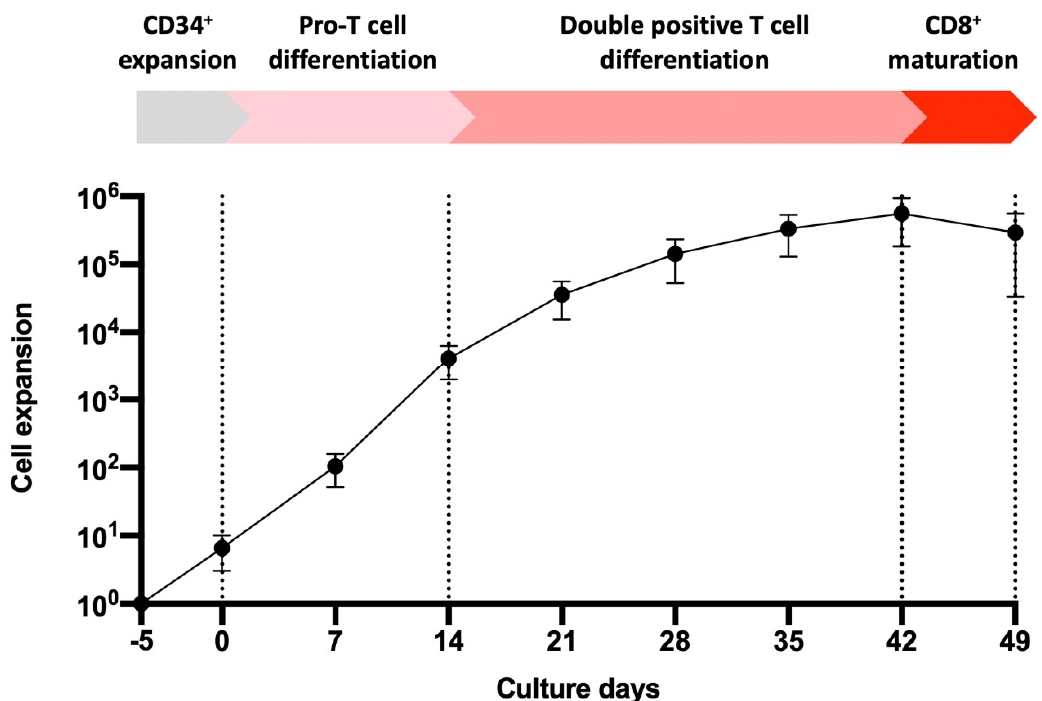
Figure 1. Umbilical cord blood (UCB)-derived CD34 + cell expansion and differentiation to T cells. Schematic of the HSC to T cell differentiation method. UCB-derived CD34 + cells were isolated and initially expanded for 5 days in CD34 Expansion media (Day − 5–Day 0, CD34 + expansion step). Differentiation to Pro-T cells was induced over 14 days (Day 0–Day 14, Pro-T cell differentiation step) and Pro-T cells to double positive (DP) T cells over an additional 28 days of differentiation (Day 14–Day 42, Double positive T cell differentiation step) in Mature media. DP to single positive (SP) T cell transition was induced by activation in cytokines for a further 7 days of differentiation (Day 42–Day 49, CD8 + maturation step) in 6F Media together with anti-CD3/CD28 bead stimulation for the first 3–4 days (CD8 + maturation step). Cumulative fold change of total live cells relative to a single HSC is shown at all steps of T cell differentiation over 49 days of culture. Data points and error bars indicate the mean fold change ± standard deviation (SD) from 5 representative UCB samples. Colors represent differentiation steps as indicated. Abbreviations: Pro-T, progenitor-T.